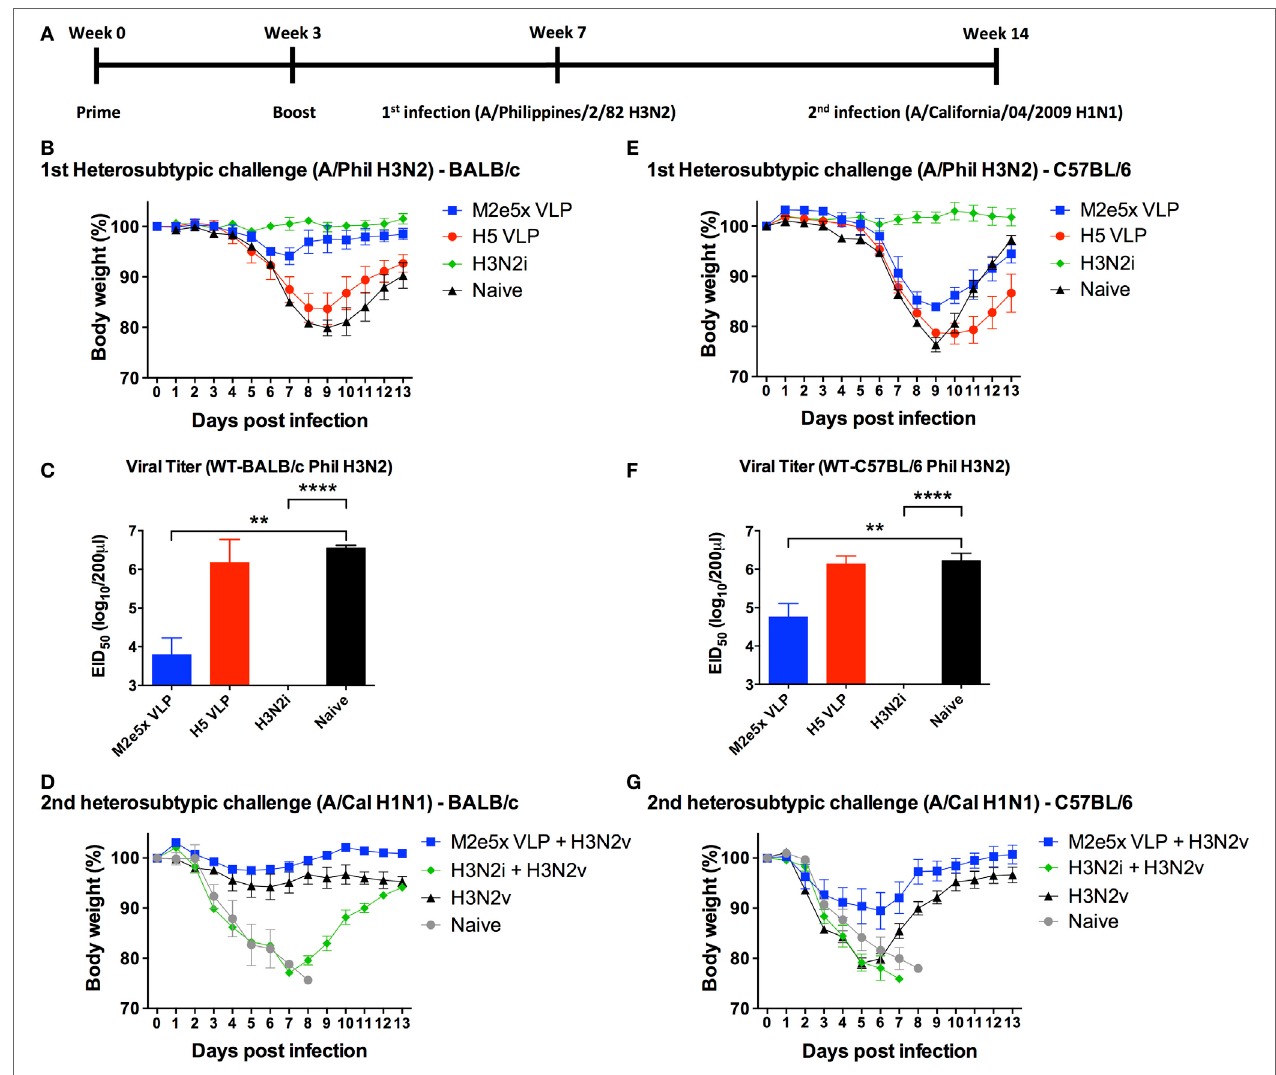
FigUre 2 | Differential efficacy of protection by M2e5x virus-like particle (VLP), H5 VLP, or H3N2i after primary H3N2 virus and secondary H1N1 virus challenge in BALB/c and C57BL/6 mice. (a) Time schedule for experiments of vaccination, first challenge infection with H3N2 virus, and second challenge infection with H1N1 virus. BALB/c (B,c) and C57BL/6 (e,F) mice were challenged with A/Philippines/2/82 (H3N2) (H3N2v) at 4 weeks after boost with M2e5x VLP, H5 hemagglutinin VLP (HA VLP), or H3N2i. Body weights were monitored for 14 days (B,e) . Lung viral titers were determined by the egg inoculation assay (c,F) . The detection limit